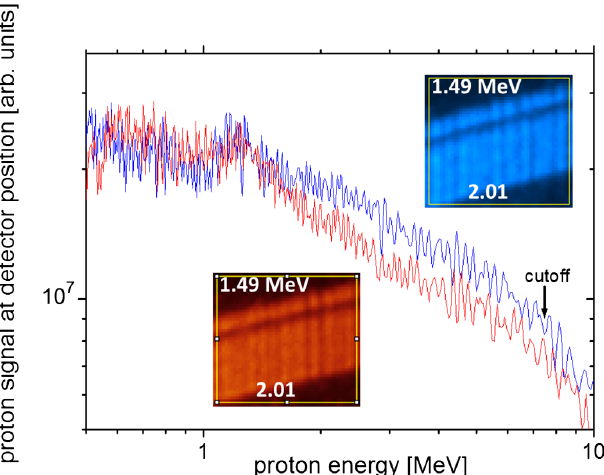
FIG. 1. Fast protons produced with laser-irradiated 5 μ m Ti foils using linear (blue line) and circular (red line) laser polarization (HC, parameters; cf. text). The proton signals are pixel counts at the pixel position (at the calculated energy position) of the detection system. Inset: Contrast-enhanced parts of the recorded proton traces.